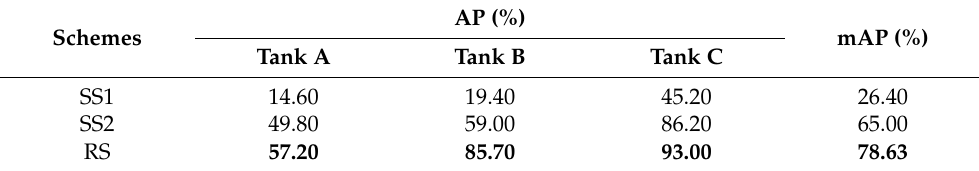
Table 4. Performance on different splitting schemes. The bold part denotes the best performance.